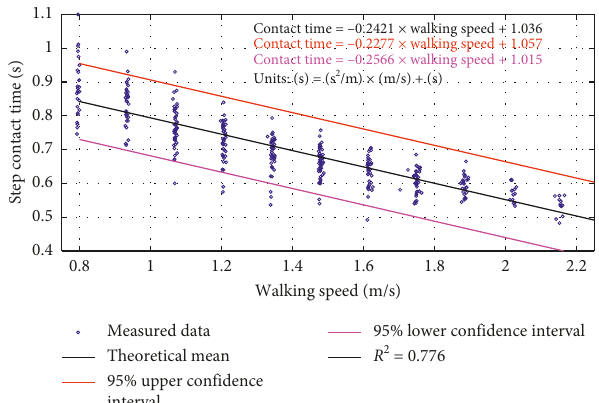
Figure 3: Statistical relationship between walking speed and step contact